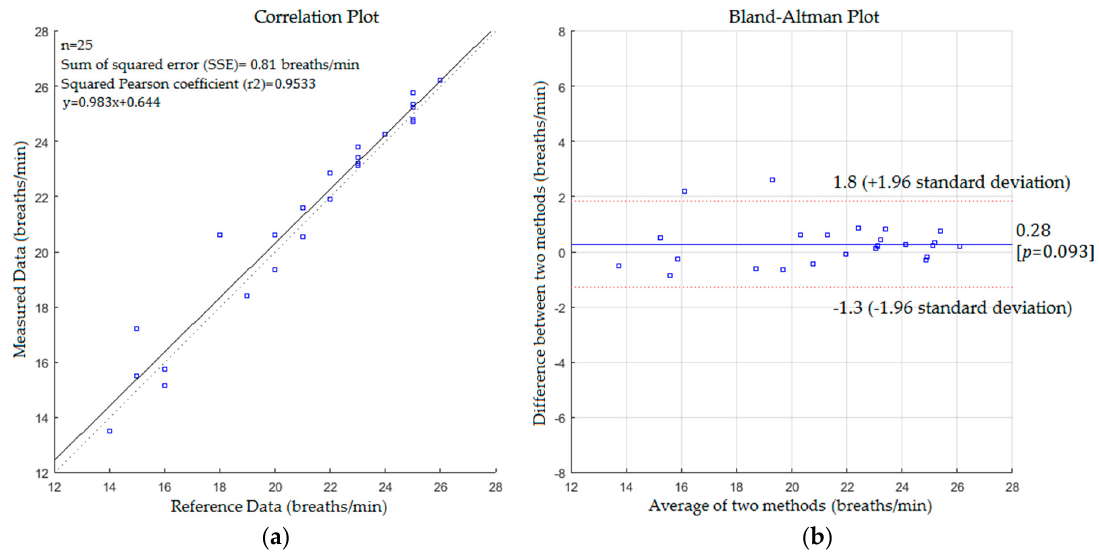
Figure 10. ( a ) Correlation plot; ( b ) Bland-Altman plot of the difference between measured data and reference data (first scenario with a blanket).